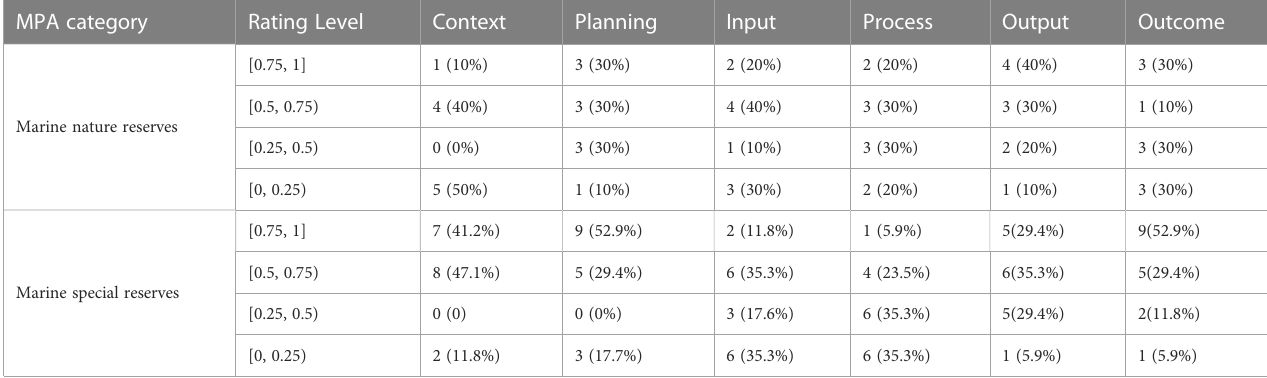
TABLE 6 Percentage of scores for each component of the 27 protected areas in the East China Sea. MPA category